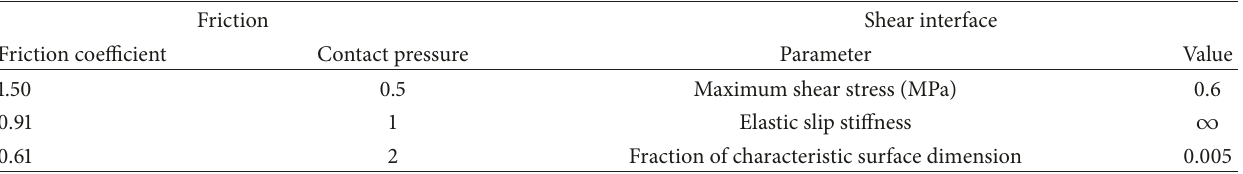
Table 2: Tangential behavior of contact interfaces between masonry bricks.